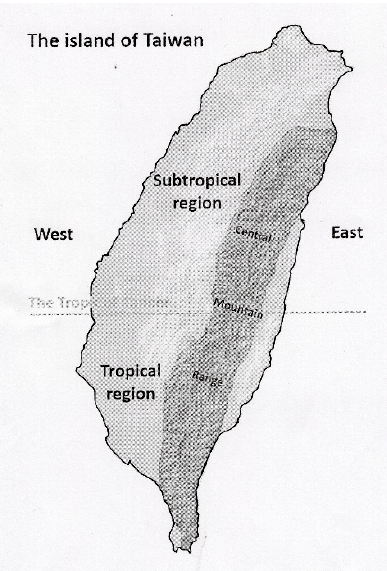
Figure 1. The subtropical and tropical regions of Taiwan. The main island of Taiwan is divided geographically into western and eastern areas by the central mountain range and climatically into tropical and subtropical regions by the Tropic of Cancer ( 23°26 ′ 12.6 ″ north of the Equator).